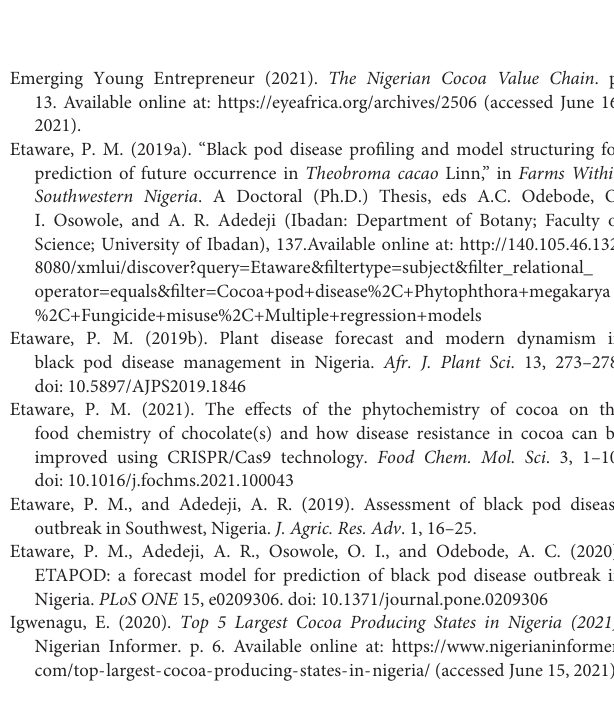
Supplementary Figure S1 | Cocoa pod infestation by Phytophthora spp. causing black pod disease. Supplementary Figure S2 | BPD outbreak evaluation for cocoa producing countries around the world. Supplementary Table S1 | The climate of some cocoa growing countries of the world. Supplementary Table S2 | The climate of cocoa producing States in